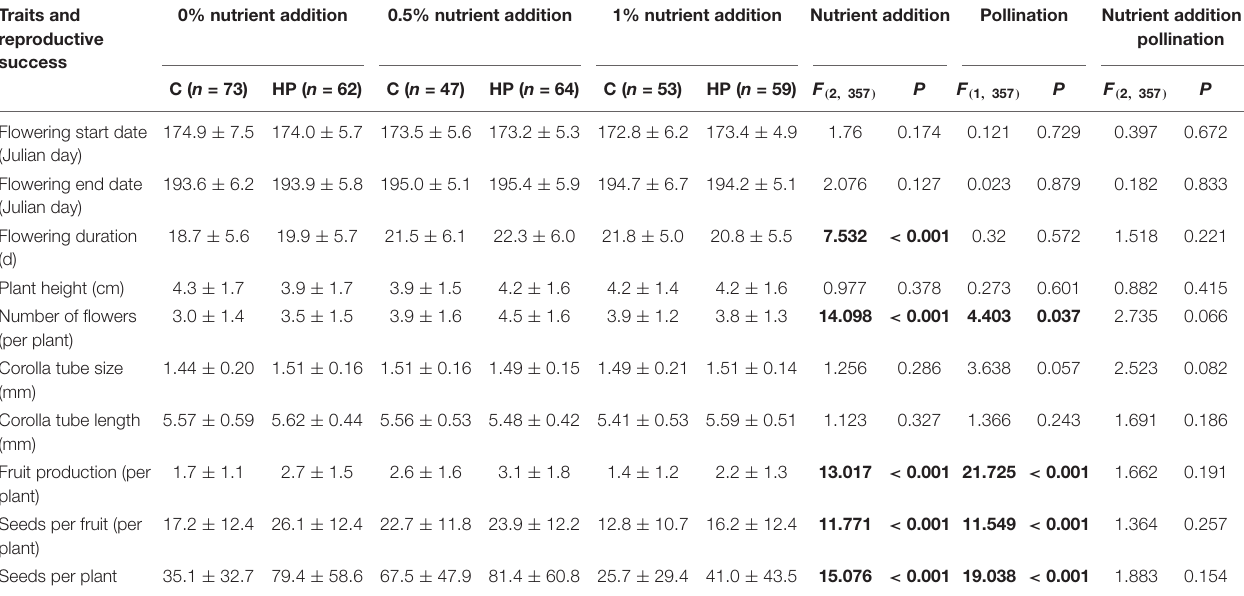
TABLE 3 | Floral traits and reproductive success (mean ± SD) of Primula tibetica in each treatment. Traits and 0% nutrient addition 0.5% nutrient addition 1% nutrient addition Nutrient addition Pollination Nutrient addition × reproductive success